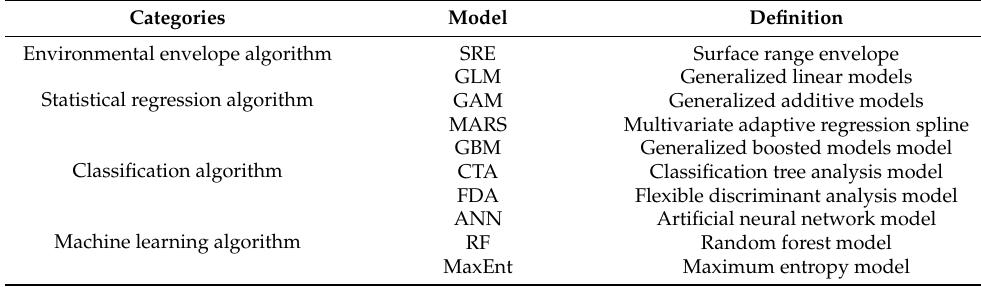
Table 2. Ten standard ecological niche